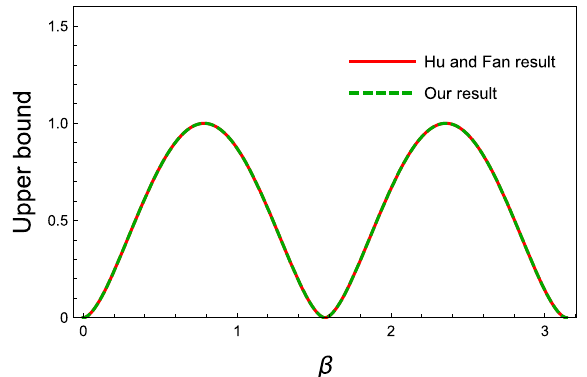
Figure 1. Different upper bounds on the shareability of QD for the state in Eq. (26), versus the state’s parameter β . The figure vividly shows that our upper bound and that of Hu and Fan will be the same. It is due to this point that for any pure state, as Eq.(26), the difference between our upper bound and Hu and Fan upper bound will be